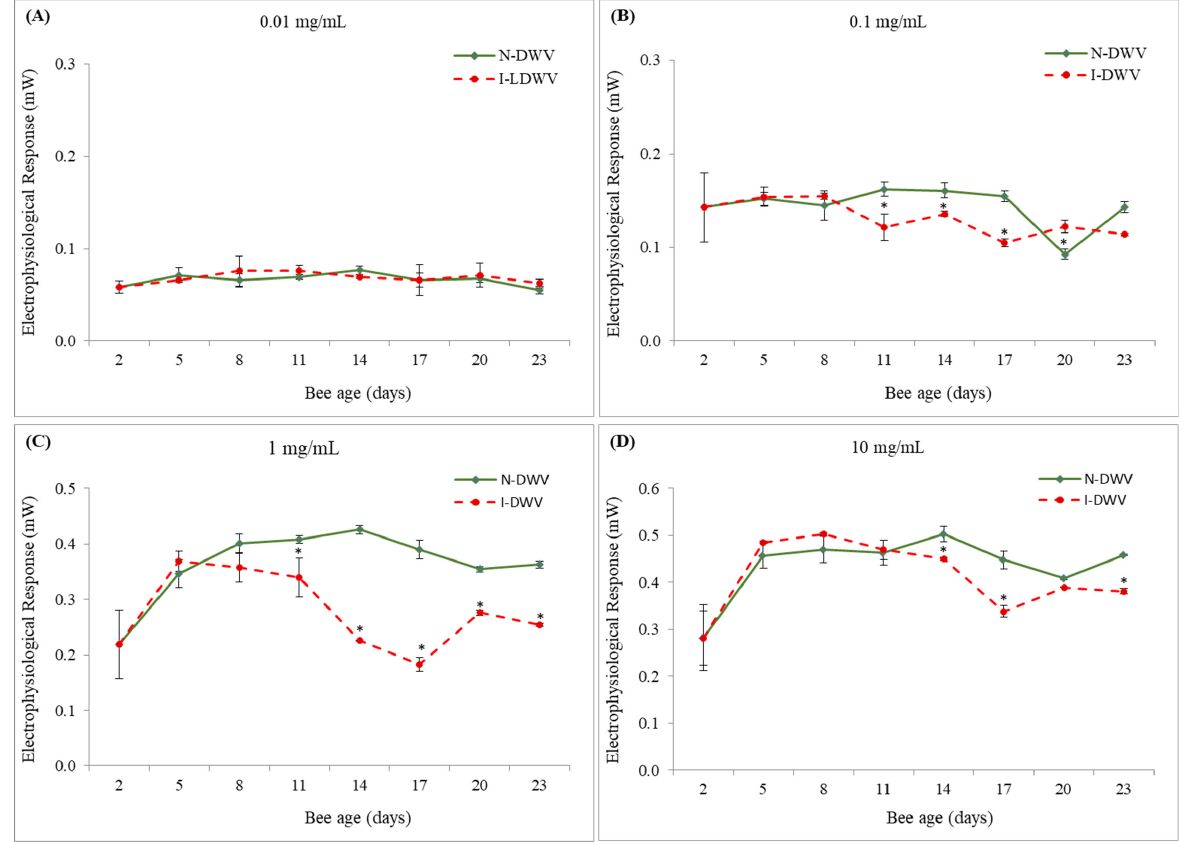
Figure 1. Electrophysiological response of inoculated and non-inoculated worker bees exposed to essential oil of Eucalyptus globulus . Uppercase letter in each subfigure represent the essential oil at concentration of ( A ) 0.01, ( B ) 0.1, ( C ) 1.0 and ( D ) 10.0 mg/mL. Asterisks indicate significant differences for the same sampling time in bees that were inoculated (I-DWV) and non-inoculated (N-DWV) with DWV-A, according to the Bonferroni test ( p < 0.05). The bar in each age indicates standard error.